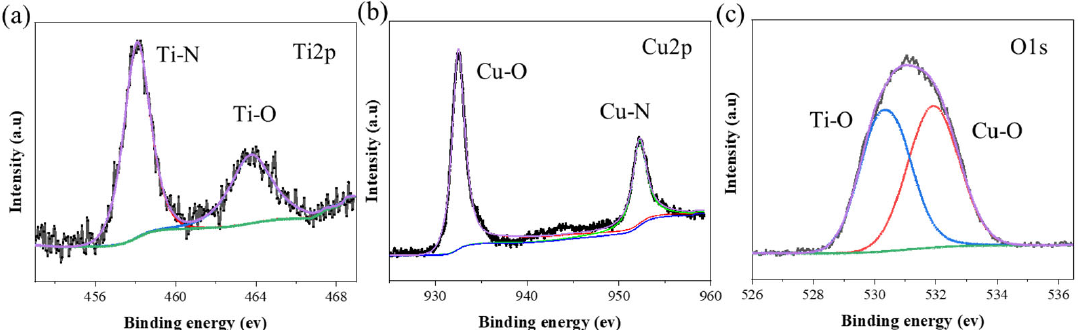
Figure 3. XPS spectra analysis (black line) and XPS fitting (purple line) on the surface of the MAO- Cu/Cu-(HEA)N composite coating: ( a ) Ti 2p (red line is Ti-N, blue line is Ti-O and green line is base line), ( b ) Cu 2p (red line is Cu-O, green line is Cu-N and blue line is base line), ( c ) O 1s (red line is Ti-O, red line is Cu-O and green line is base line).